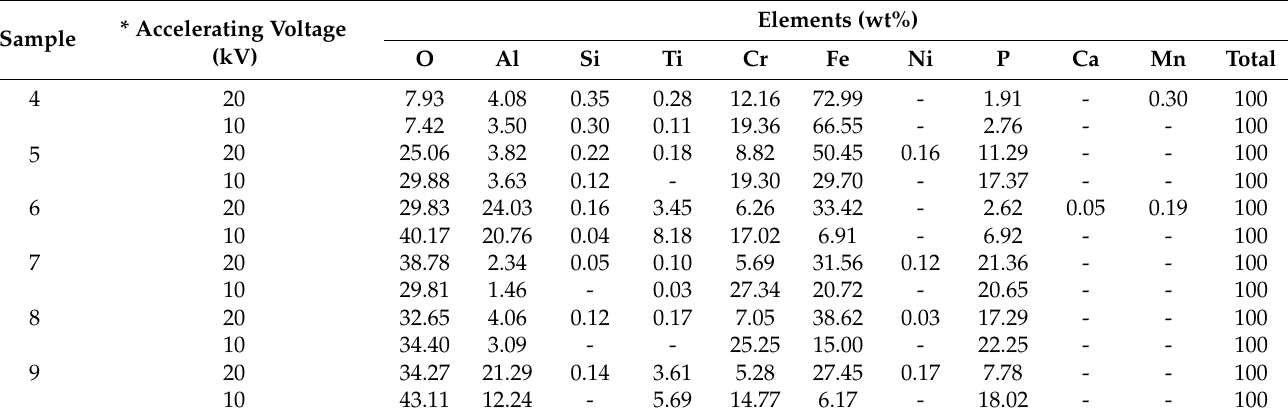
Table 2. Elemental composition of Fe-Cr-Al foil in the initial state and after